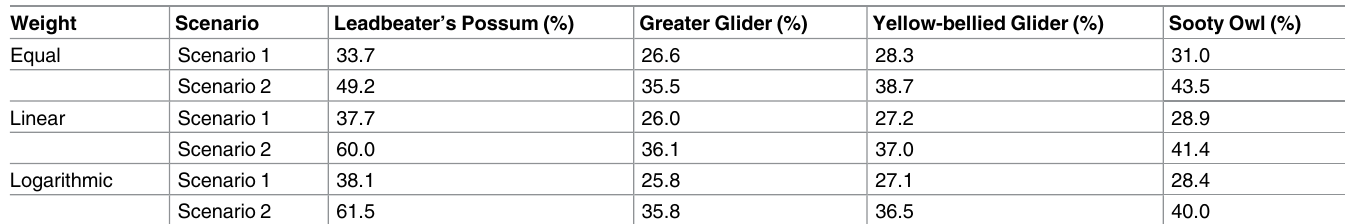
Table 4. Percentages of the cumulative values for the four target species across all of the cells included in the expanded reserve scenarios.